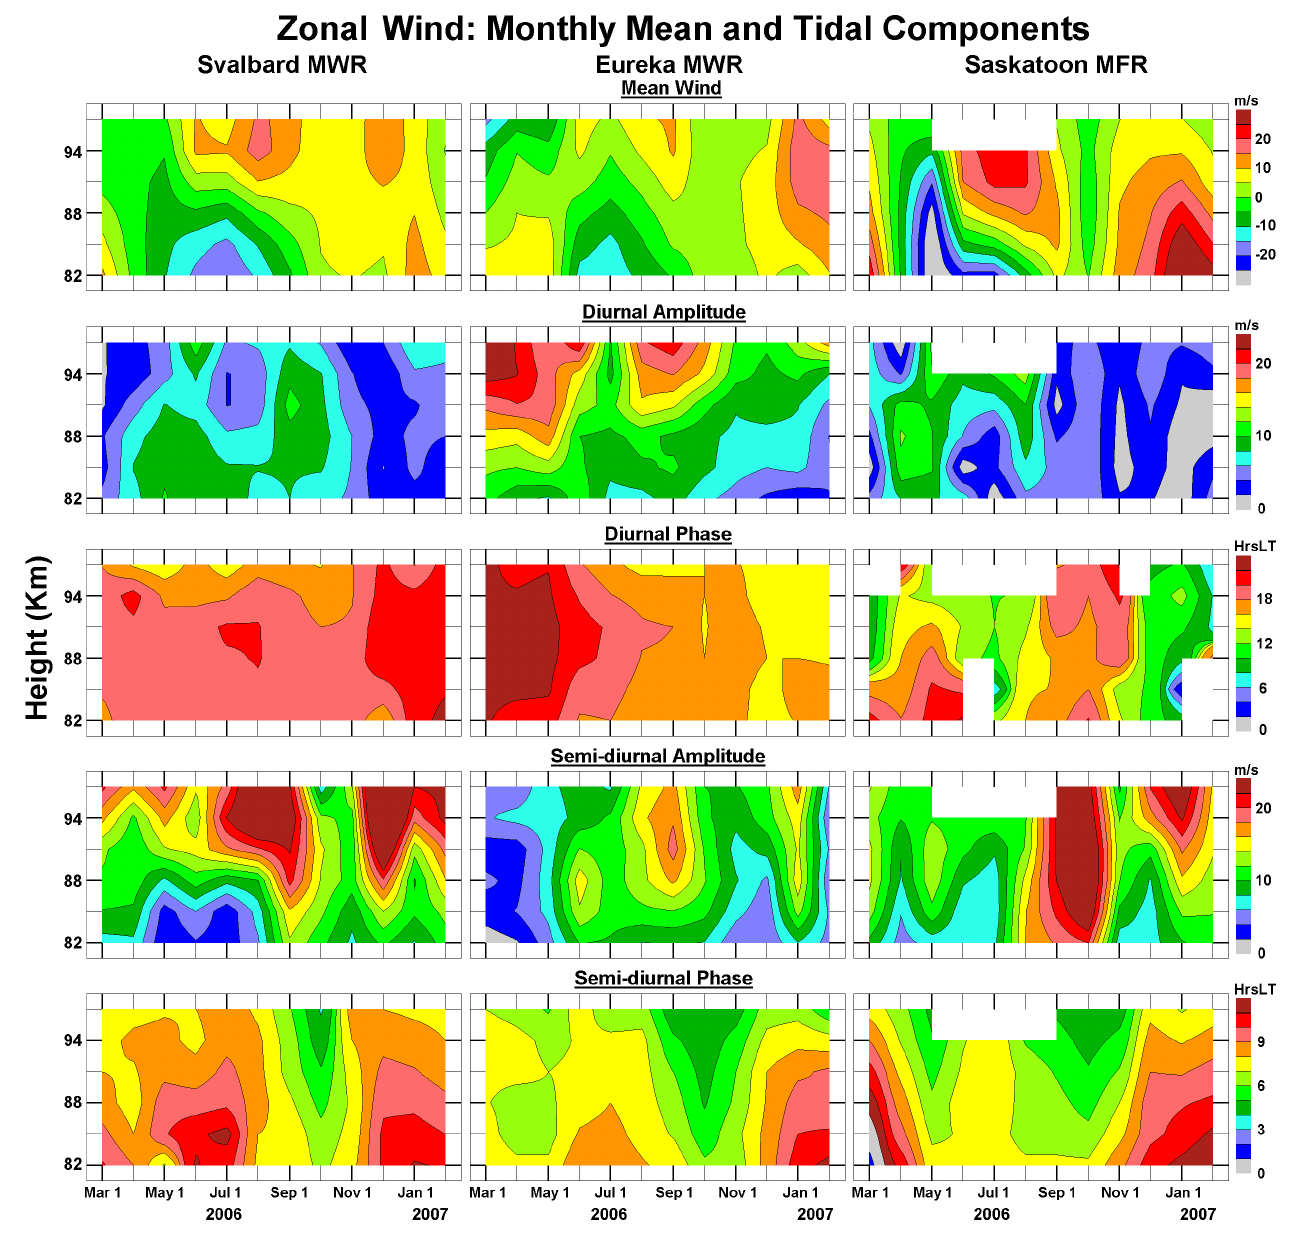
Fig. 4. Zonal winds for mean background winds and the tides, both diurnal (24-h) and semidiurnal (12-h). Eastward tidal winds are taken as positive, and the phases are the local solar times of maximum eastward winds. Heights above 94km in mid-summer at Saskatoon are judged to be above the heights of total reflection for the MFR and therefore are not